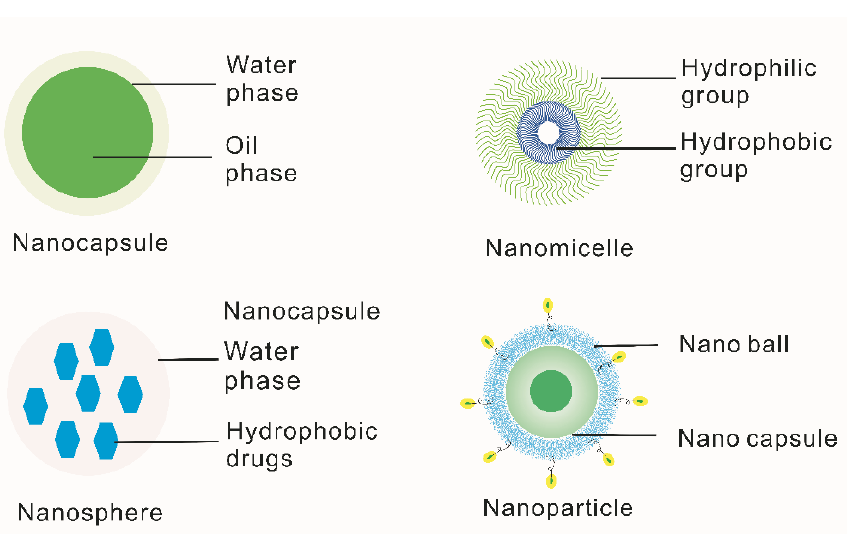
Figure 3. Classification and introduction of special biomimetic nanocarriers for ophthalmic diseases. Nanocapsules are nanoscale vesicle systems composed of nontoxic polymer membranes [65]. Na- nomicelles are amphiphilic block copolymers [66]. Microspheres are tiny spherical entities formed by wrapping or adsorbing drugs in a polymer matrix [67]. Nanoparticles are granular dispersions or solid particles of size 10 – 1000 nm [68]. Nanoemulsions consist of oil, water, surfactant and cosurfactant [69]. Liposomes are artificial membranes. The hydrophilic head of phospholipid mole- cules is inserted into water and the hydrophobic tail of the liposome extends to the air. After agita- tion, the spherical liposome of double - lipid molecules is formed [70]. Dendrimers are a class of mac- romolecules with a highly branched structure obtained by the stepwise repetitive reaction of den- drimer elements [71]. Hydrogel is a kind of hydrophilic three - dimensional network structure gel [72] . 3.1. NAD Carriers in Gene Therapy for Eye Diseases As mentioned above, the two major factors limiting NAD therapy are the efficiency and safety of NAD delivery. The current paper focuses primarily on efficiently and accu- rately delivering NADs to target cells and minimizing safety concerns. The eye has a unique physiological structure and protective mechanisms, such as the ocular blood – aqueous humor and the blood – retina physiological barriers that protect it from external infestations [73]. However, this also results in low bioavailability of the drug after the ocular administration of the carrier. Safe, accurate, and rapid administration of